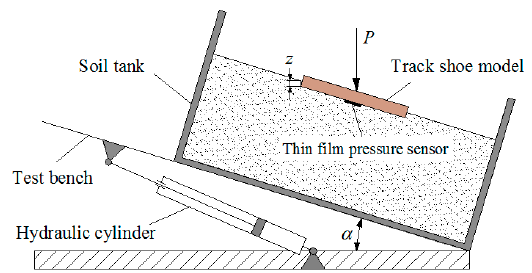
Figure 12. Track shoe model and pressure sensor.